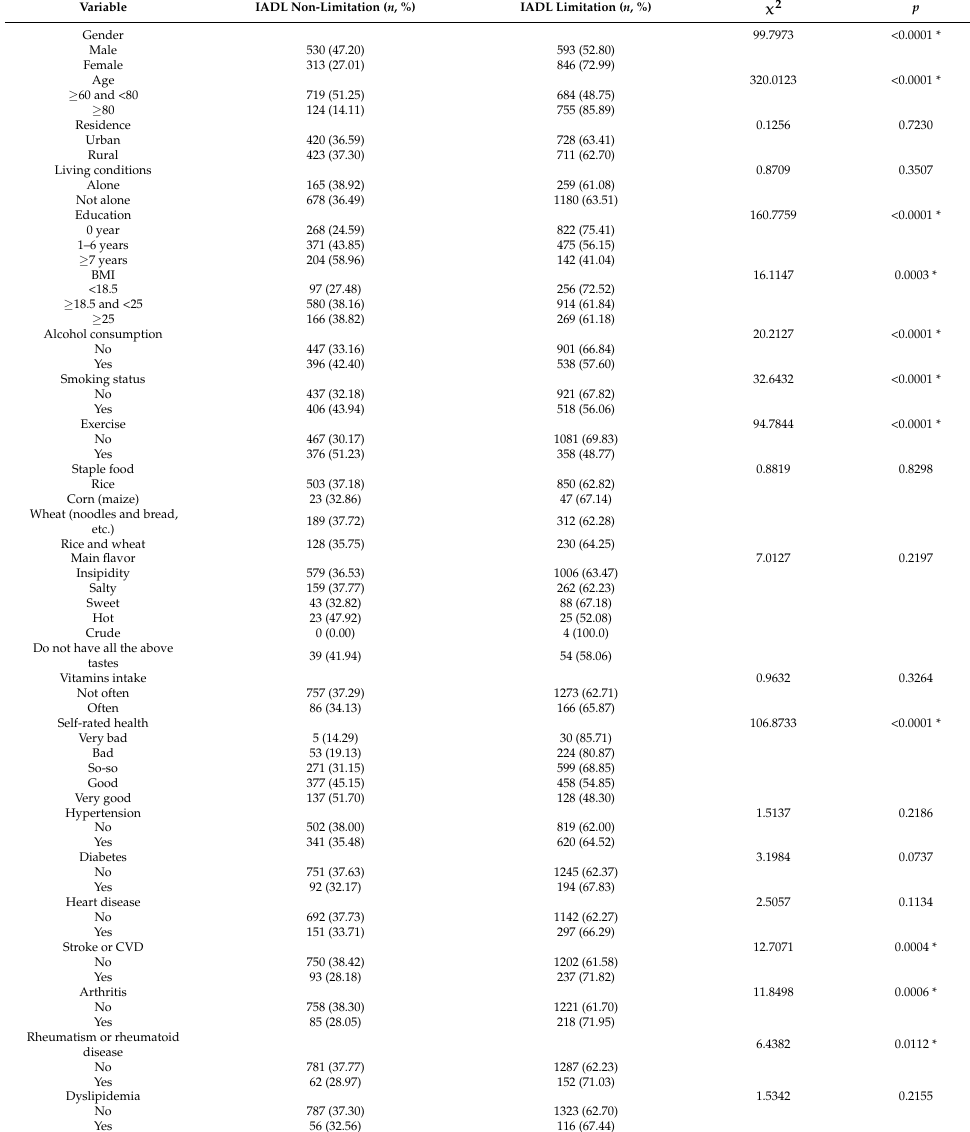
Table 2. Baseline characteristics of IADL non-limitation group and IADL limitation group ( n =